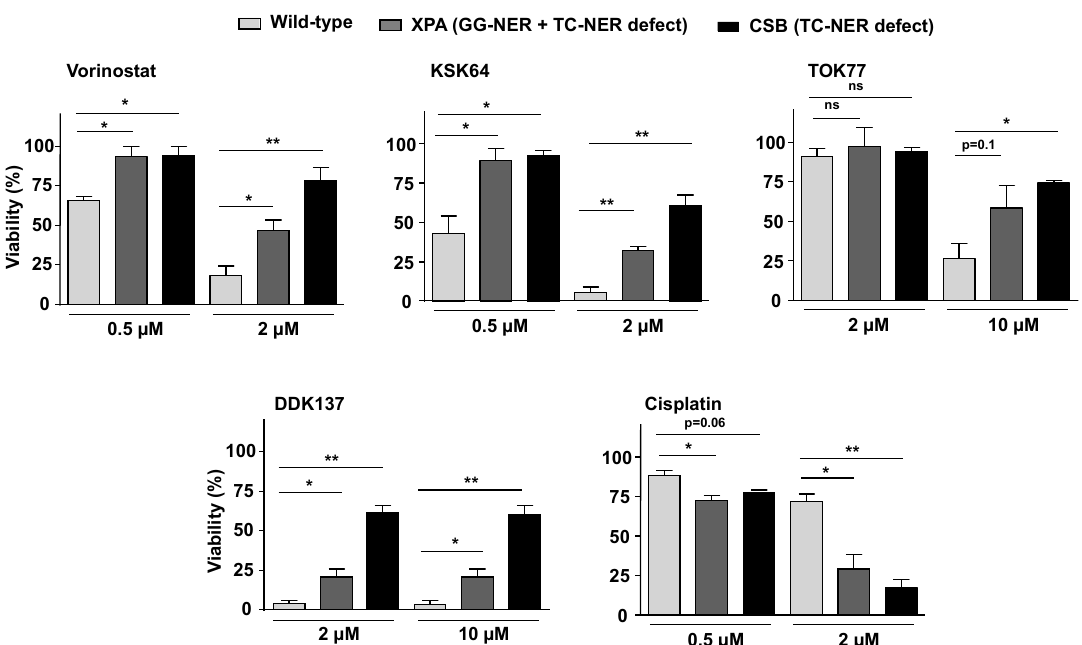
Figure 7. Sensitivity of nucleotide excision repair (NER) defective cells to hydroxamic acid- and benzamide-type HDACi. Viability of wild-type human fibroblasts and fibroblasts defective in nucleotide excision repair (NER) pathways (i.e. global genome nucleotide excision repair (GG-NER) or transcription-coupled nucleotide excision repair (TC-NER)) due to a defect in Xeroderma pigmentosum group A protein (XPA) or Cockayne syndrome protein B (CSB), respectively, was analyzed 72 h after the addition of HDACi by the Alamar blue assay, as described in Methods. The DNA intrastrand cross-linking agent cisplatin was used for control. Data shown are the mean ± SD from three independent experiments (n = 3) each performed in triplicate (N = 3); ns, not significant; *, p ≤ 0.05; **, p ≤ 0.01 as compared to the corresponding untreated controls (Student´s t-test).